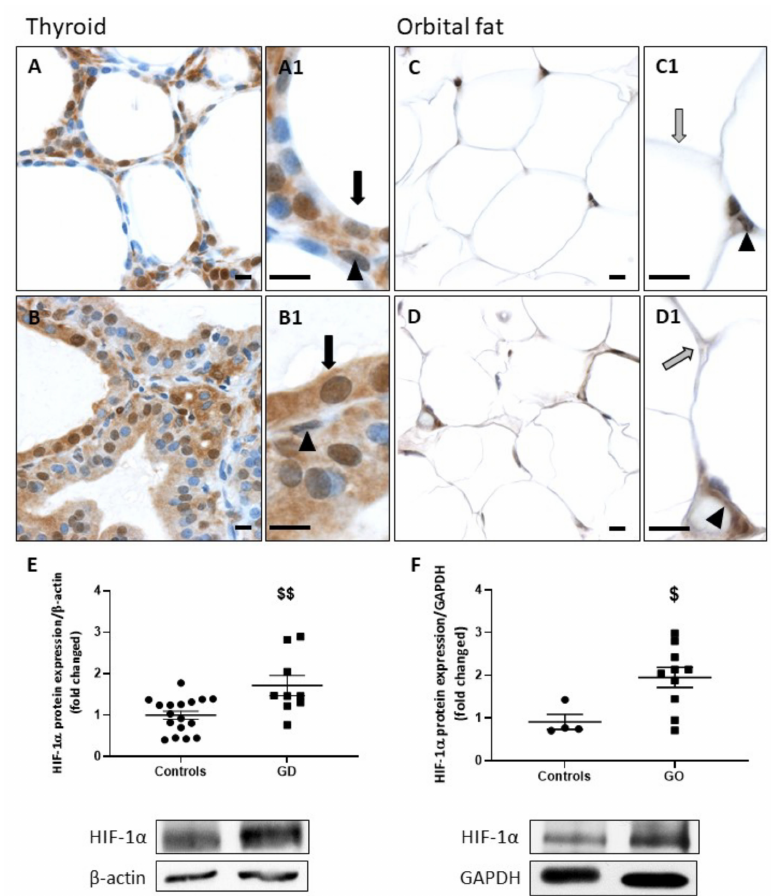
Figure 2. Increase of HIF-1 α in GD thyroids and GO orbital fats. HIF-1 α staining was higher in GD thyroids ( B ) than in controls ( A ). Similarly, GO orbital adipocytes presented a stronger expression of HIF-1 α ( D ) compared to controls ( C ). Endothelial cells presented no difference in HIF-1 α staining. ( A1 – D1 ) Thyrocytes are indicated by black arrows, adipocytes by gray arrows, and endothelial cells by arrowheads. Scale bars = 10 µ m. Western blot analysis revealed that HIF-1 α was significantly increased in GD ( E ) and GO patients ( F ). Data represent the mean ± SEM from 17 controls and 9 GD thyroids and from 4 controls and 10 GO orbital fats. $ p < 0.05 and $$ p < 0.01 compared to controls. Densitometric values were normalized against β -actin or GAPDH. Western blots shown are representative of both